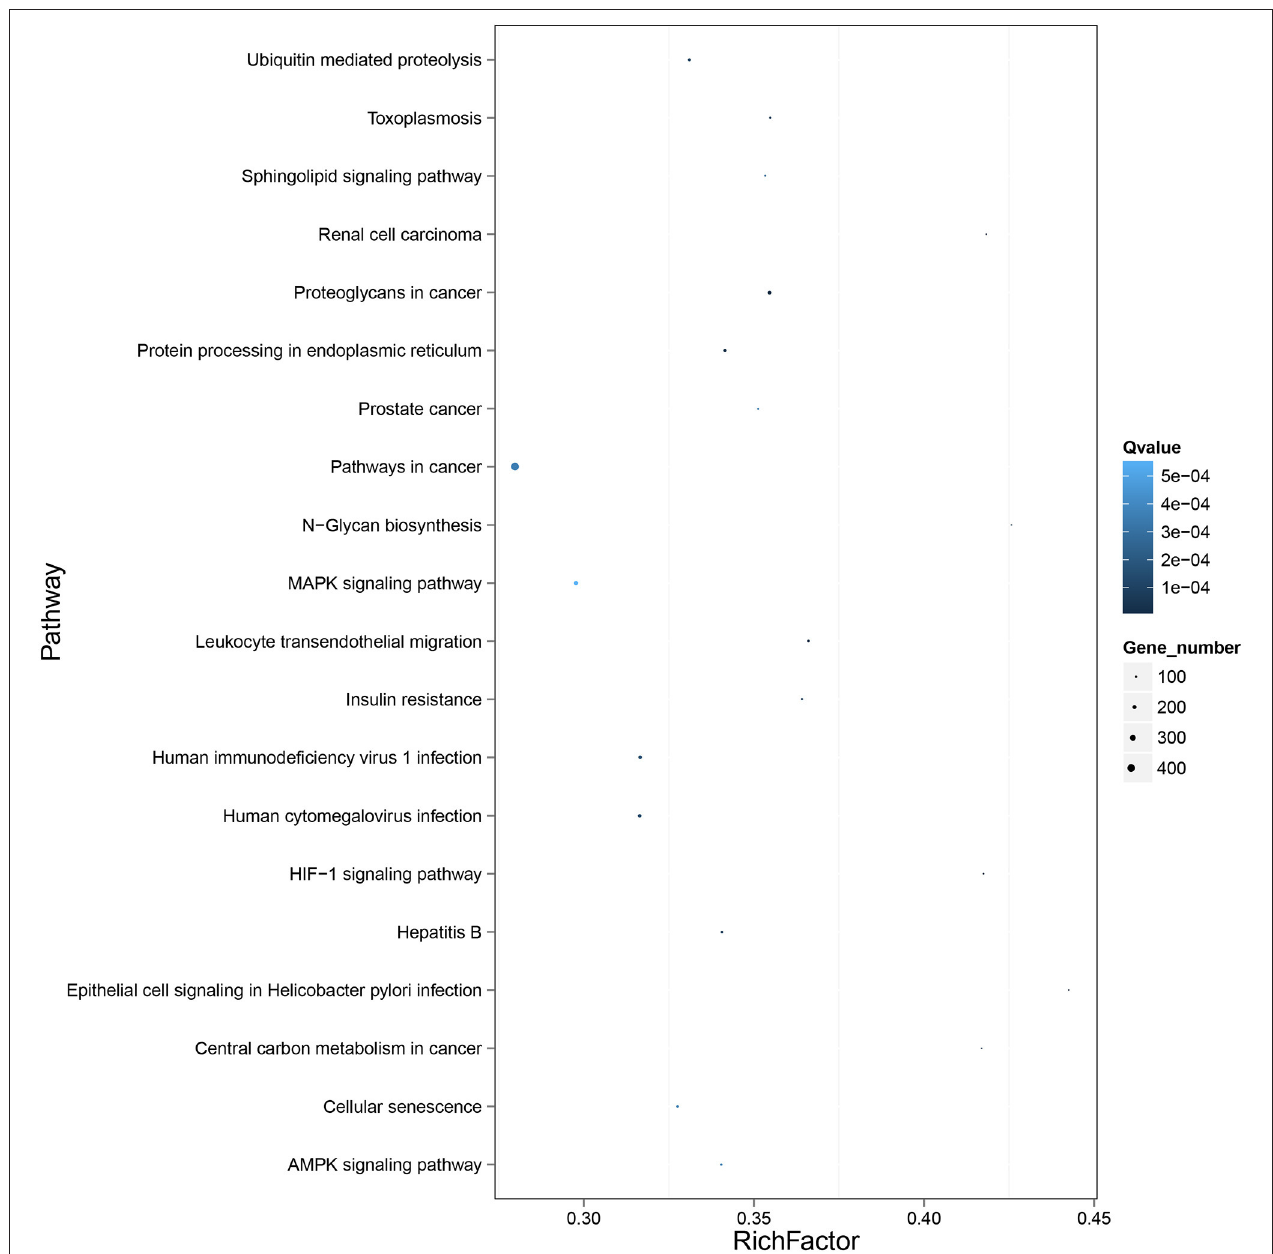
FIGURE 6 | KEGG pathway enrichment analysis of the DE mRNAs with the 20 highest rich ratios. The size of dots indicates the number of enriched genes, and the color of dots indicates the degree of enrichment. Higher rich ratio correlate with lower Q-values, indicating that the enrichment of DE genes in a given pathway is